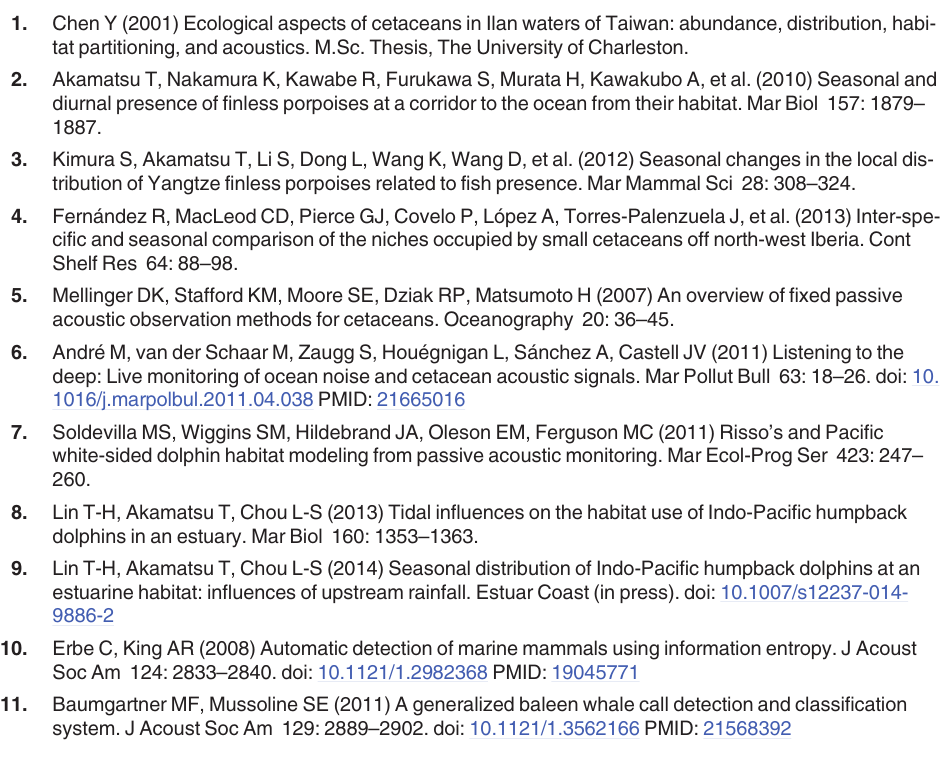
S2 Fig. Variation of whistle usage in odontocete recordings collected from the onboard sur- vey. There were 50 recording files (total length: 3.35 hr) with an acceptable SNR of odontocete whistles. Each data point represents each recording file after principle component analysis. Whistle usage on seven species were analyzed, including bottlenose dolphins Tursiops trunca- tus (red), false killer whales Pseudorca crassidens (green), Fraser's dolphins Lagenodelphis hosei (blue), short-finned pilot whales Globicephala macrorhynchus (magenta), Risso ’ s dolphins Grampus griseus (cyan), spinner dolphins Stenella longirostris (yellow), and spotted dolphins Stenella attenuata